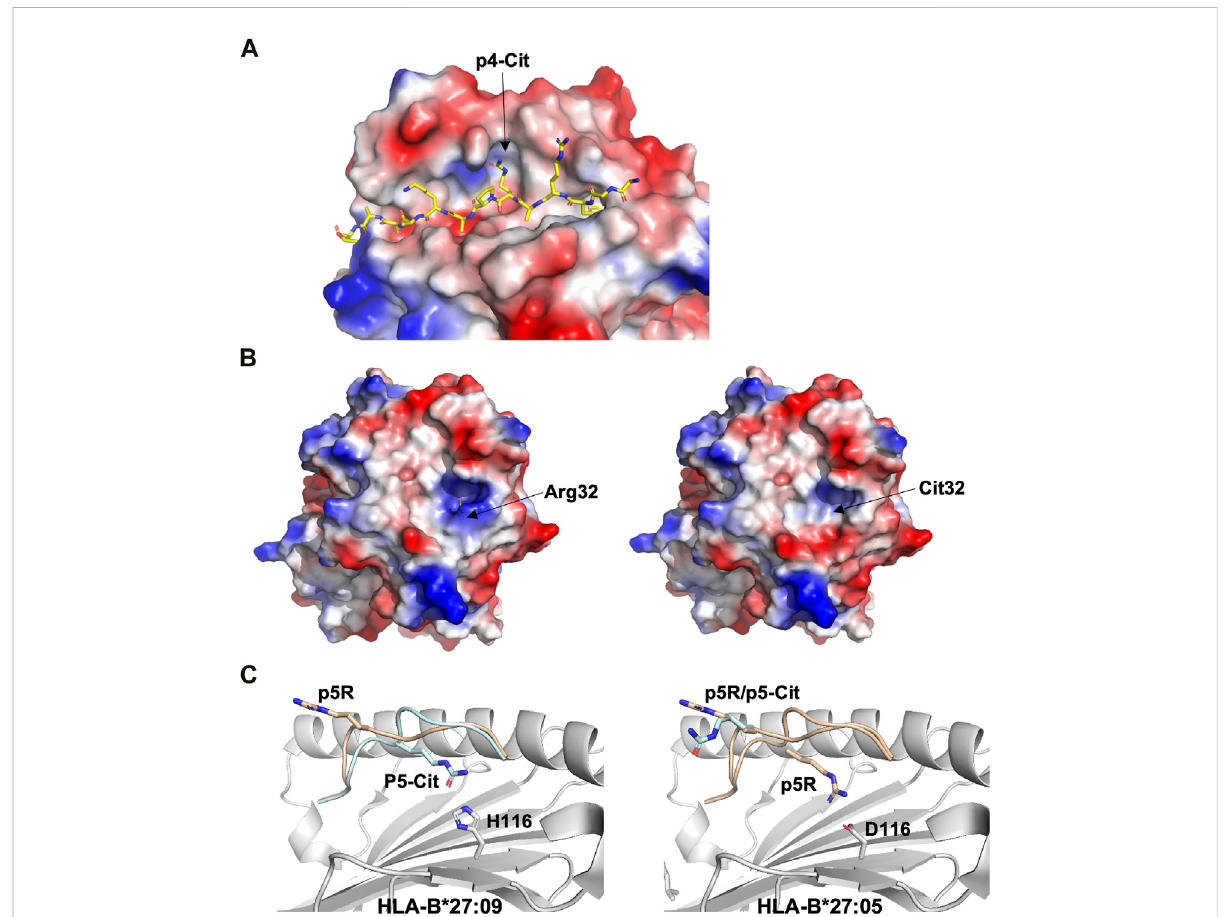
FIGURE 4 Citrullination may allow binding of neoantigens to MHC, modify surface electrostatics and alter the conformations of presented peptides (A) . The side chain of a citrullinated arginine residue can bind to the slightly positively charged pocket 4 in HLA-DRB1*04:01 while the side chain of an arginine residue will be repelled, as exempli fi ed here by the crystal structure of the citrullinated fi brinogen peptide (6BIL.pdb) (Ting et al., 2018). The peptide,coloredinyellow,bindstothecleftofHLA-DRB1*04:01withtheN-andC-terminiextendingtotheleftandrightofthepeptidebinding cleft,respectively.Thesidechainofthecitrullinatedresidueatp4isindicated,bindingtotheslightlypositivelychargedpocket4inHLA-DRB1*04:01. The surface of HLA-DRB1*04:01 is colored according to surface electrostatics, with negatively and positively charged regions in red and blue, respectively (B) . Citrullination of peptides may result in modi fi cation of the pMHC surface electrostatic potential, as exempli fi ed by the surfaces of HLA-DRB1*04:01 in complex with the wild-type enolase-derived epitope eno 26-40 (5LAX.pdb, left) or with the citrullinated PTM variant (5JLZ.pdb, right) (Gerstner et al., 2016). Here, citrullination reduces signi fi cantly the size of the positively charged region, possibly leading to the selection of alternative TCRs. Both structures are presented from the TCR view (C) . The conformation of the self-peptide VIRP 400-408 depends on the MHC-I allele it binds to. Wild-type VIRP 400-408 binds to HLA-B*27:09 with the side chain of the arginine residue p5R protruding towards the solvent and a presumptive TCR (1OGT.pdb, colored in light orange, left panel). Citrullination of p5R in VIRP 400-408 modi fi es signi fi cantly the conformation of the PTM peptide compared to wild-type VIRP 400-408 . The side chain of p5R in the citrullinated VIRP 400-408 dives instead within the cleft of B*27: 09 forming hydrogen bonds with the side chain of H116 (3B3I.pdb, colored in blue, left panel). VIRP 400-408 takes two different conformations when binding to HLA-B*27:05, one similar to the one described for the HLA-B*27:09/VIRP 400-408 complex and one diametrically different in which the peptide fl ips and the side chain of p5R forms hydrogen bonds with the side chain of the HLA-B*27:05 aspartate residue D116 (1OGT.pdb, colored in light orange, right panel). Importantly, citrullination of p5R forces the formation of only one peptide conformation in which the side chain of the citrulline residue protrudes towards the solvent (3B6S.pdb, colored in light blue, right panel) (Beltrami et al.,